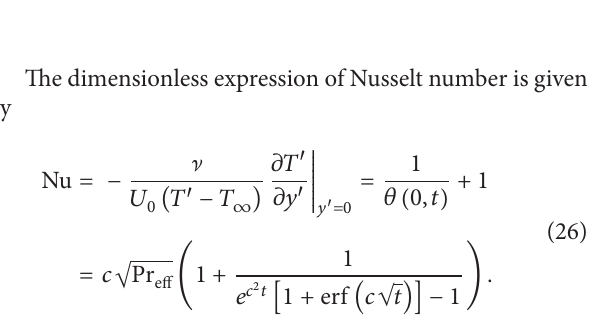
Figure 3: Velocity profiles for different values of 𝑅 when 𝑡 = 0.2, Pr = 0.71, Gr = 2, Gm = 3, Sc = 0.94, 𝛾 = 1 , and 𝜔 = 𝜋/4